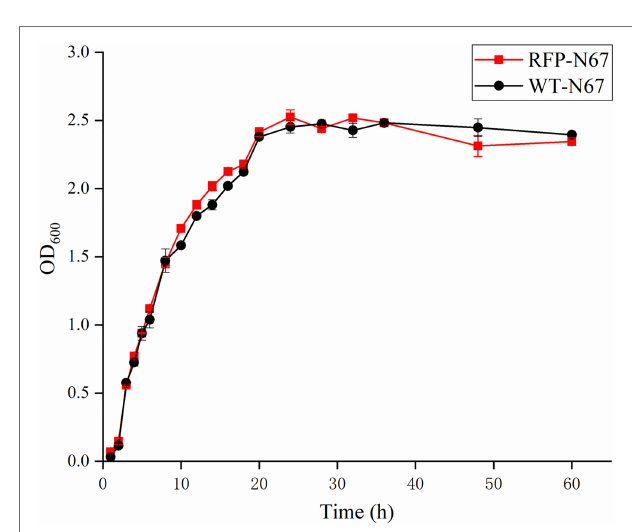
FIGURE 3 | Fluorescence plasmid retention frequency of RFP-labeled Bacillus . Samples were taken every 5 h. The proportion of colonies on a non- resistant plate with fluorescence was assessed (with three replicates) under fluorescence microscope to determine the frequency of plasmid retention.